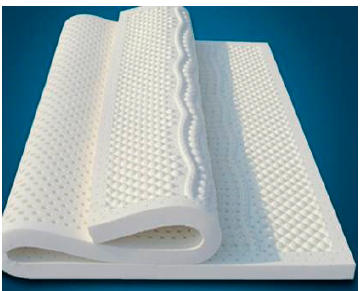
Figure 1. Rubber latex foam structure under naked eye observation.